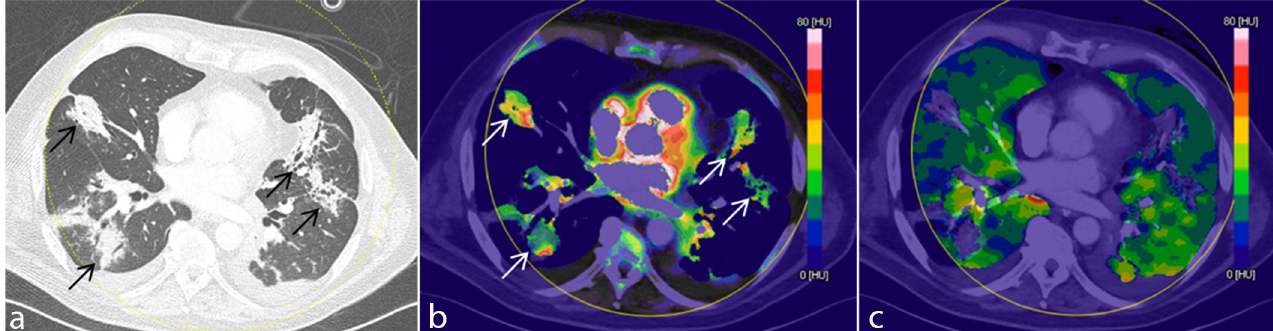
Fig 3. Iodine uptake in normally aerated lung and consolidation. Three reconstructions of the identical slice position, a. MPR in lung window, b. colour-coded PBV MIP with thresholds for tissue recognition set to minimum -100 HU and maximum + 150 HU for visualization of iodine density in consolidation and c. colour-coded PBV MIP with thresholds for tissue recognition set to minimum -960 HU and maximum -600 HU for visualisation of iodine density in normally aerated lung. Parameter settings were separated for this illustration only in order to enable a clear depiction of perfusion differences by optimizing the range of the look-up table to tissue density. Consolidations (arrows) demonstrated a higher iodine density as compared to normally aerated lung (see colour-coding scale).